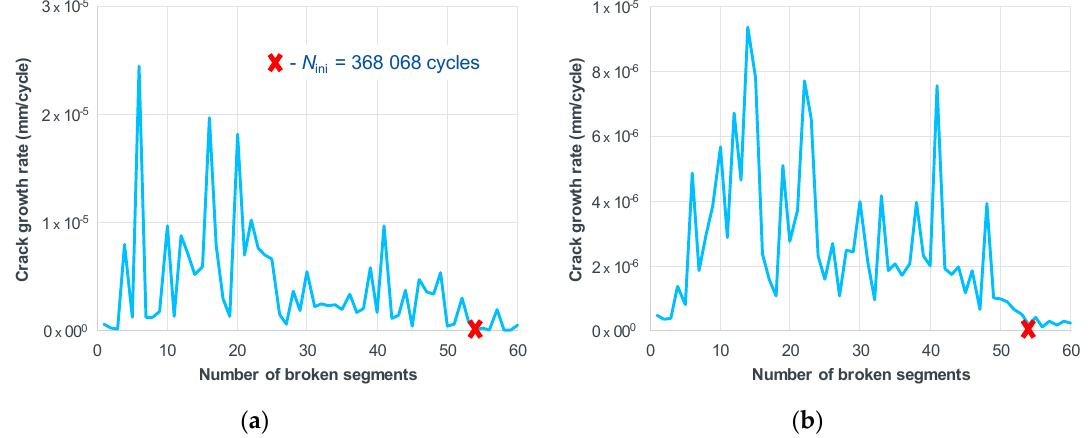
Figure 10. ( a ) Fatigue crack growth rate of the Fe 99.9% at the end of the crack initiation stage; ( b ) Averaged fatigue crack growth rate of the Fe 99.9%.